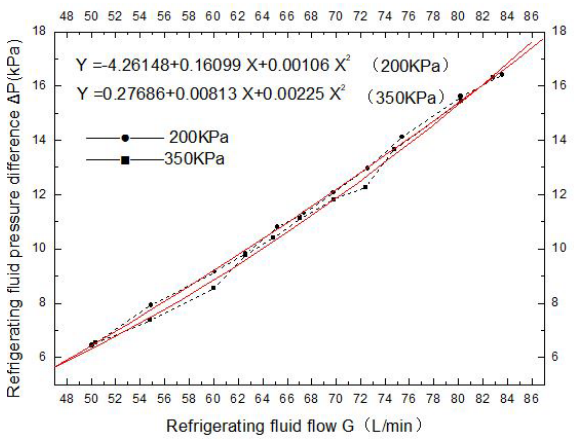
Figure 6. Variation of pressure drop with flow rate (temperature 20 ◦ C).